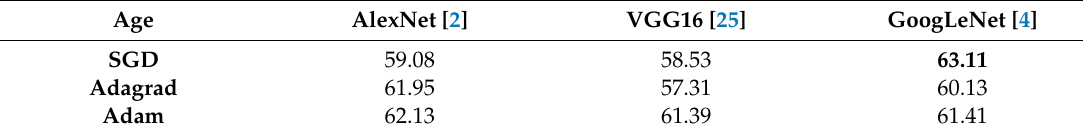
Table 12. Age classification results of the CACD2000 database by the three CNNs.